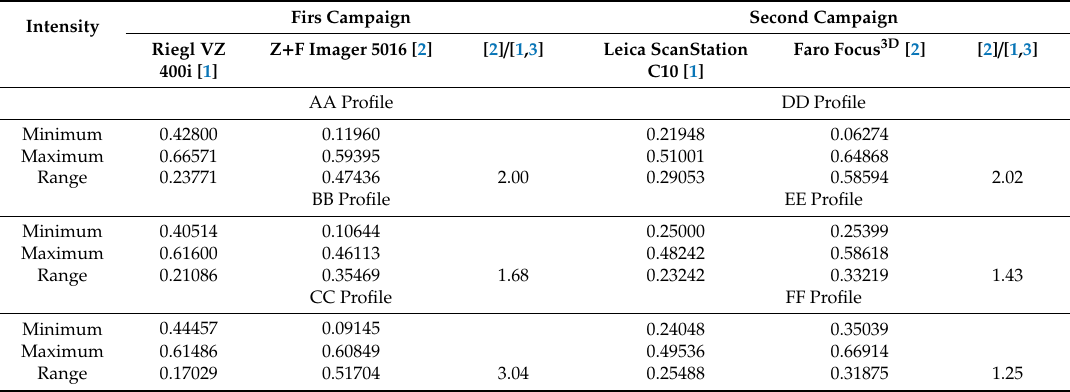
Table 2. Summary of the basic statistics of the intensity values for the tested